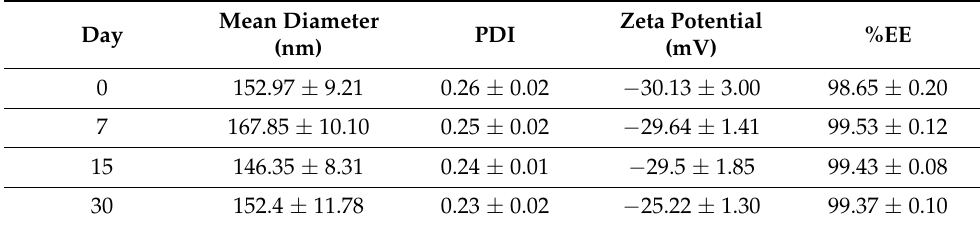
Table 3. Mean size, PDI, zeta potential, and %EE of LPNP-TS-DOX stored at 2–8 ◦ C, protected from the light, for up to 30